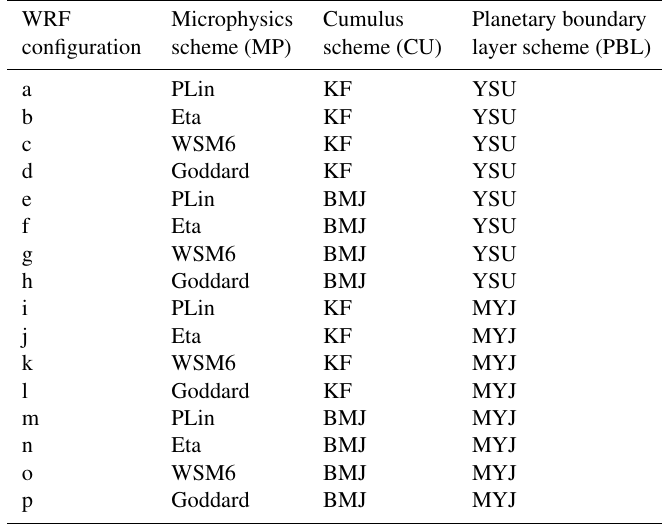
Table A1. List of different WRF